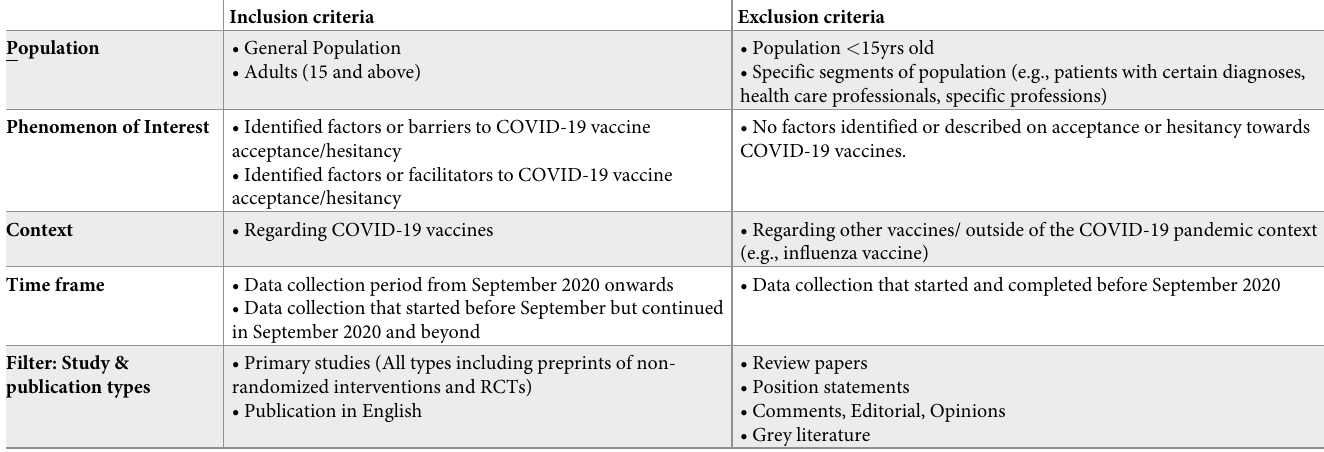
Table 1. Selection